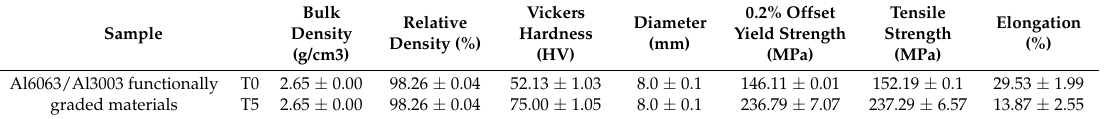
Table 3. Experimental mechanical properties of Al6063/Al3003 FGM (T-0, T-5).